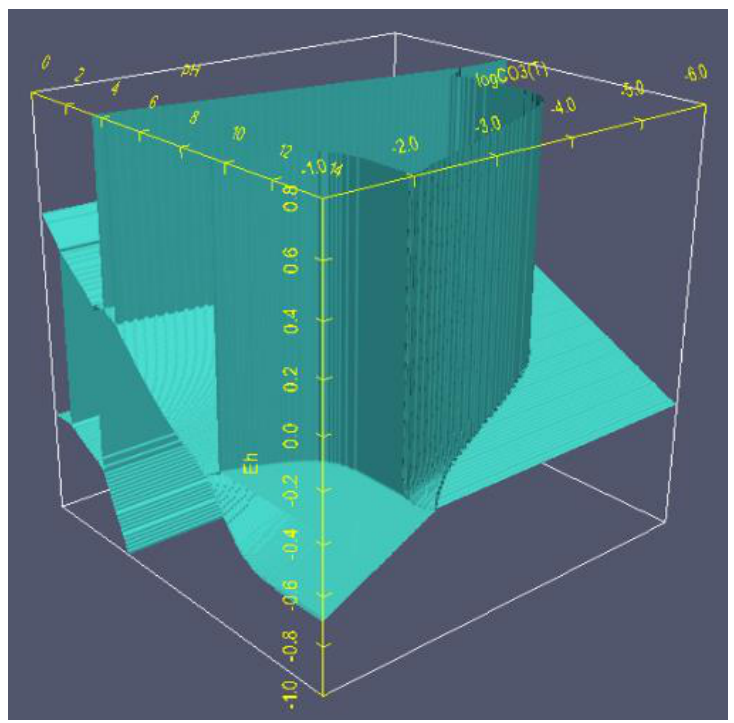
Figure 31. 3D plot that shows the boundaries (contour) between species.